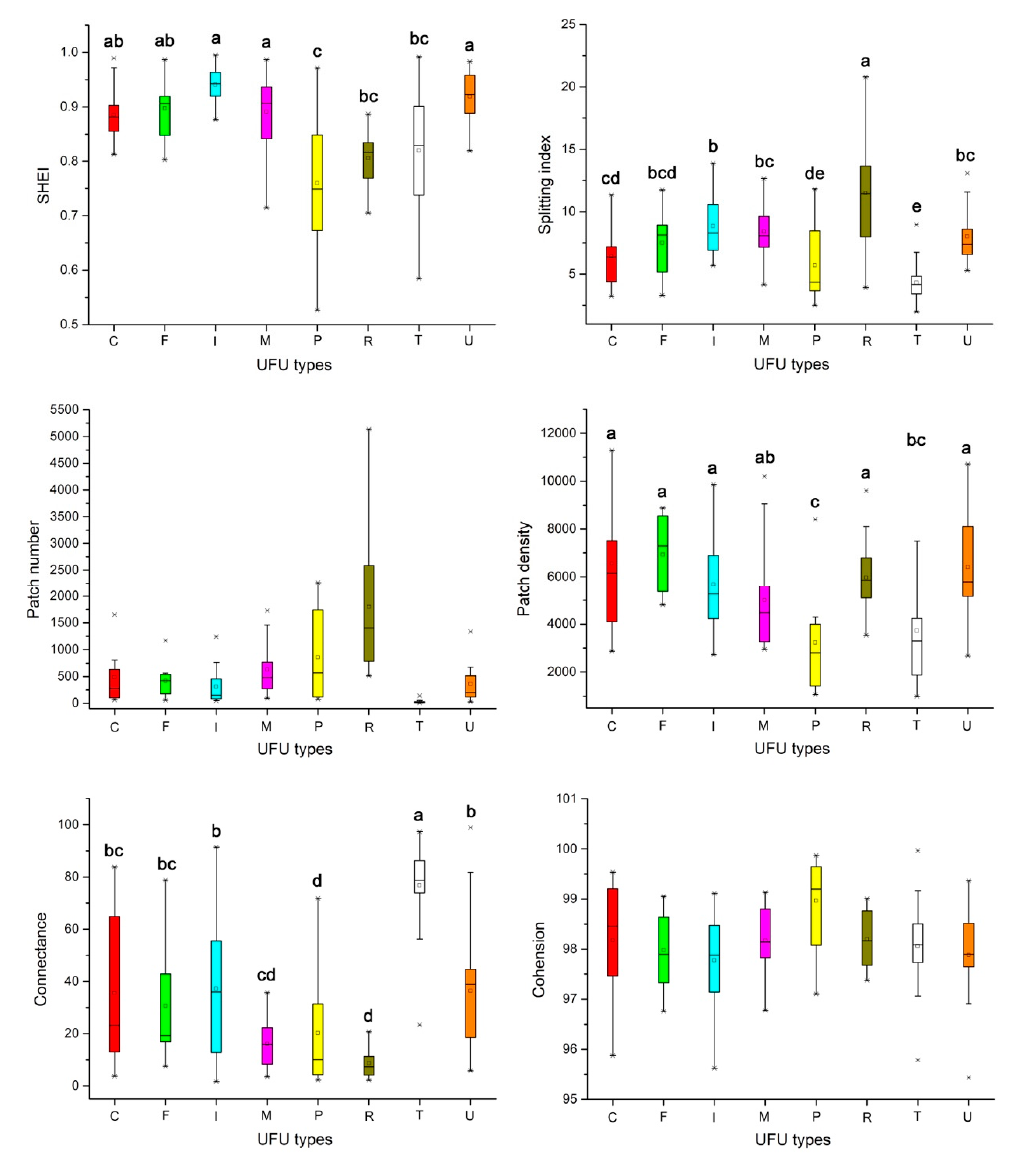
Figure 3. The distribution of the landscape metrics of green space among eight UFU types.